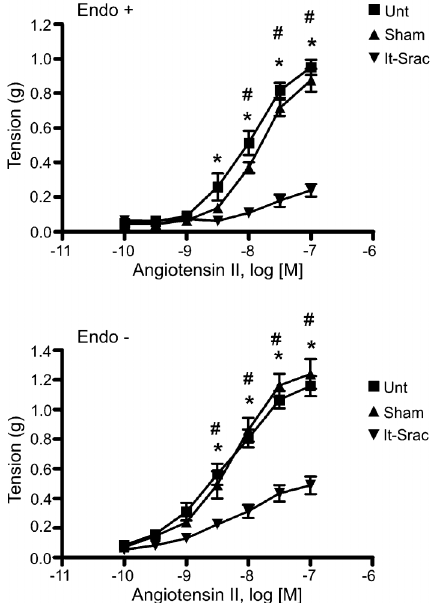
Figure 1. Contractile responses to angiotensin II in rat thoracic aortas under pressure overload. Cumulative concentration- response curves to angiotensin II were developed in endothe- lium-intact (Endo++) and endothelium-denuded (Endo-) thoracic aortic segments obtained from rats 8 weeks after suprarenal abdominal aortic coarctation (lt-Srac) or sham surgery (Sham). Age-matched untreated rats (Unt) were also used as controls. Data are reported as means±SE in grams of developed force (n=16). *P , 0.05, Unt vs lt-Srac; # P , 0.05, Sham vs lt-Srac (two- way ANOVA with the Bonferroni post hoc